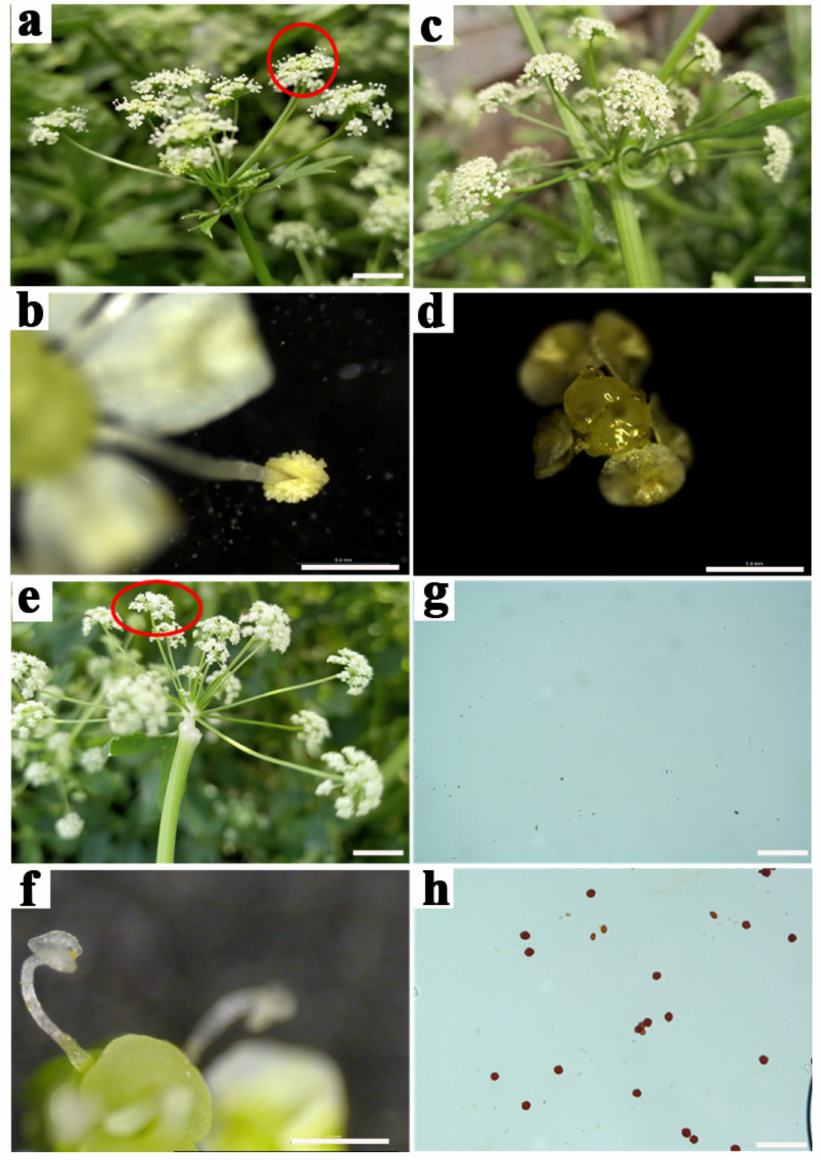
Figure 1. Phenotype of flowers from the celery CMS line W99A and its maintainer line W99B. ( a ) Flower of maintainer line W99B; ( b ) anther of maintainer line W99B; ( c ) flower of completely sta- men degeneration type; ( d ) anther of completely stamen degeneration type; ( e ) flower of incomplete stamen degeneration type; ( f ) anther of incomplete stamen degeneration type; ( g , h ) TTC staining for pollen viability of the celery CMS line W99A and its maintainer line W99B. ( a , c , e ) scale = 5 cm; ( b , f ) scale = 0.4 mm; ( d ) scale = 0.8 mm; ( g , h ) = 200 µ